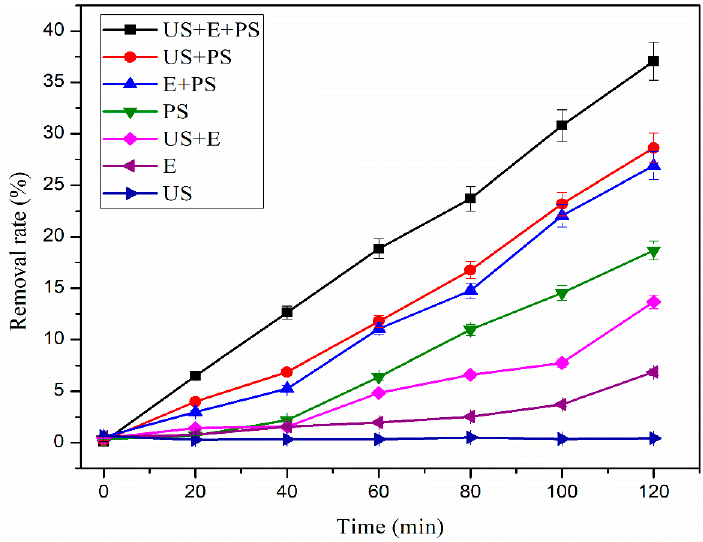
Figure 2. Removal effect of ciprofloxacin by different reaction systems.